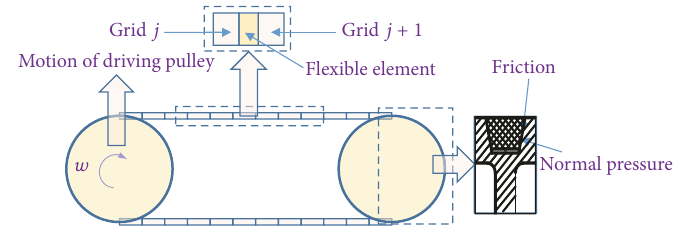
Figure 2: Multibody dynamics model of belt drive